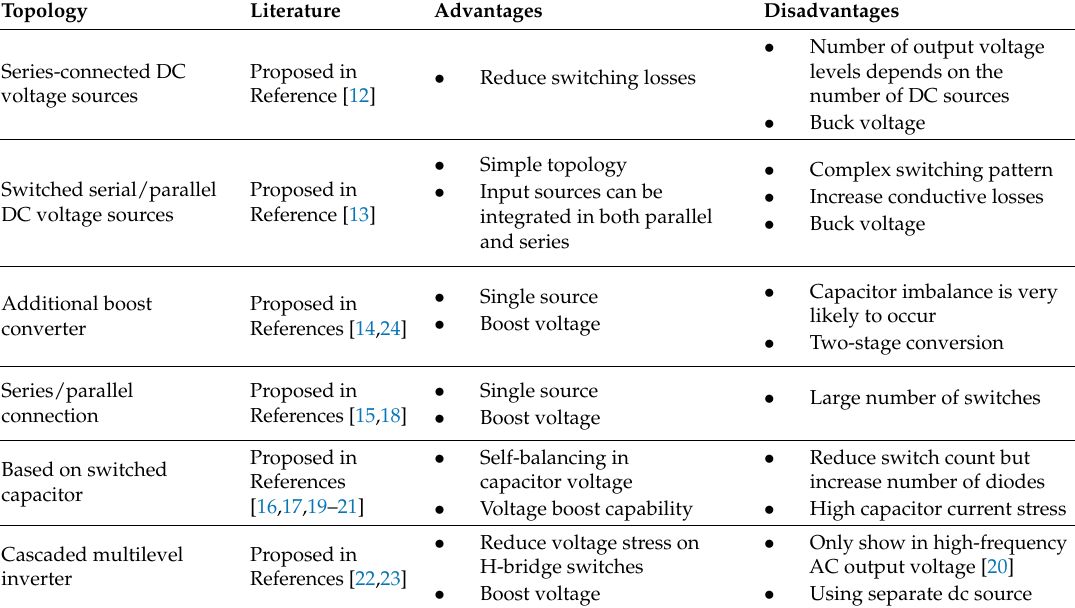
Table 1. Advantages and disadvantages of multilevel inverters with reduced switch